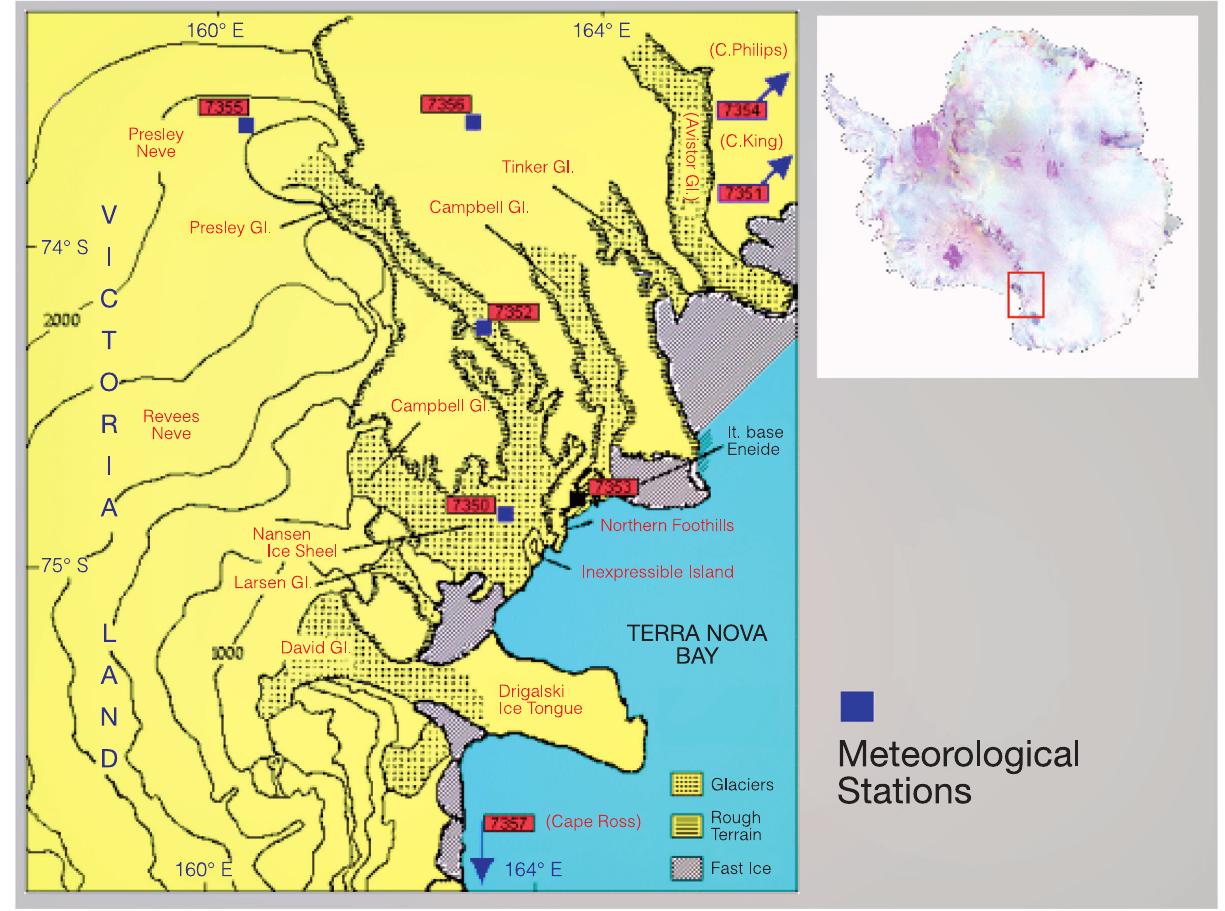
Fig. 3. The Italian mesoscale AWS